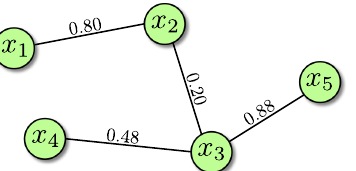
Figure 1. An example of a Constraint Satisfaction Problem (CSP)